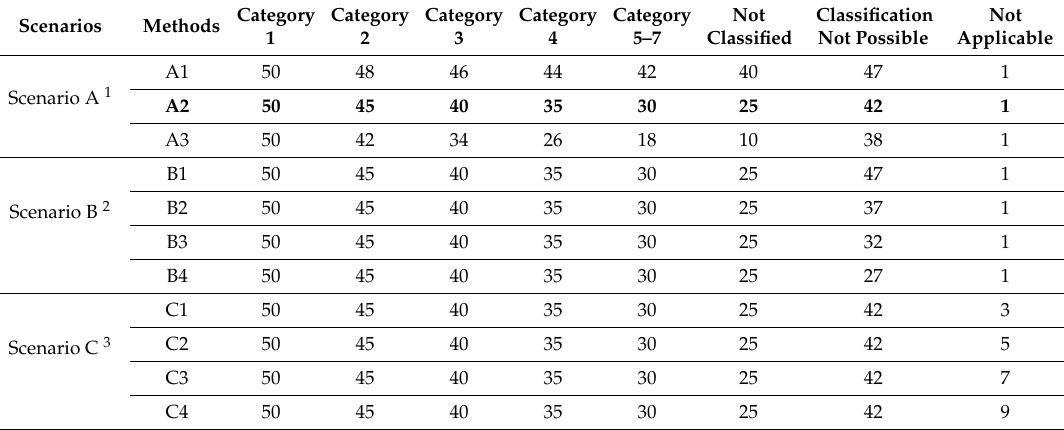
Table 5. Quantification results of hazard variables using three